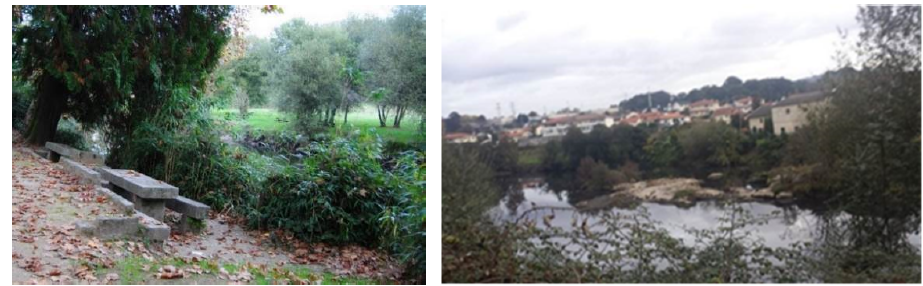
Figure 7. Aspects associated with Section F.